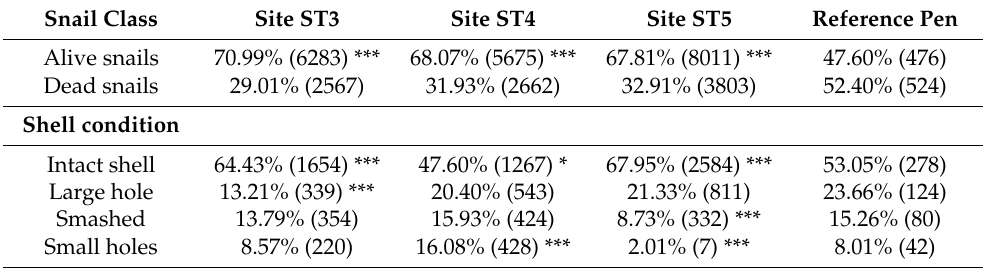
Table 3. Distribution of snail survival classes for different types of “sandwich”